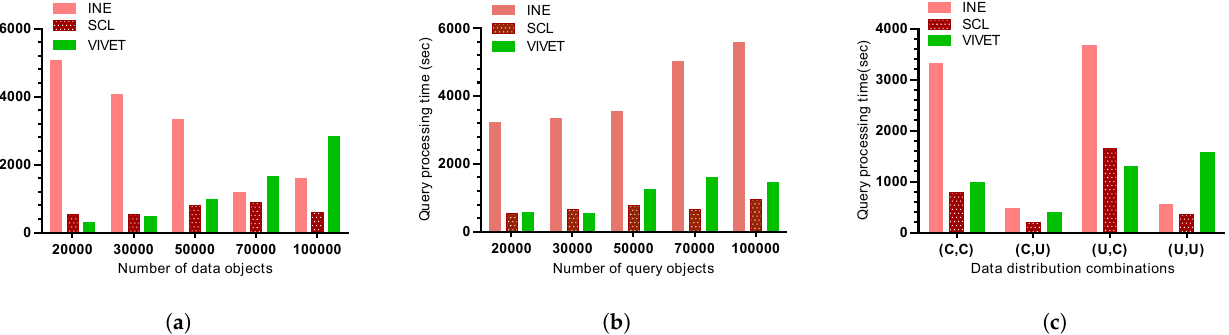
Figure 8. Comparison of INE, SCL, and VIVET for SANJ: ( a ) varying D; ( b ) varying Q; ( c ) varying the distribution of objects.